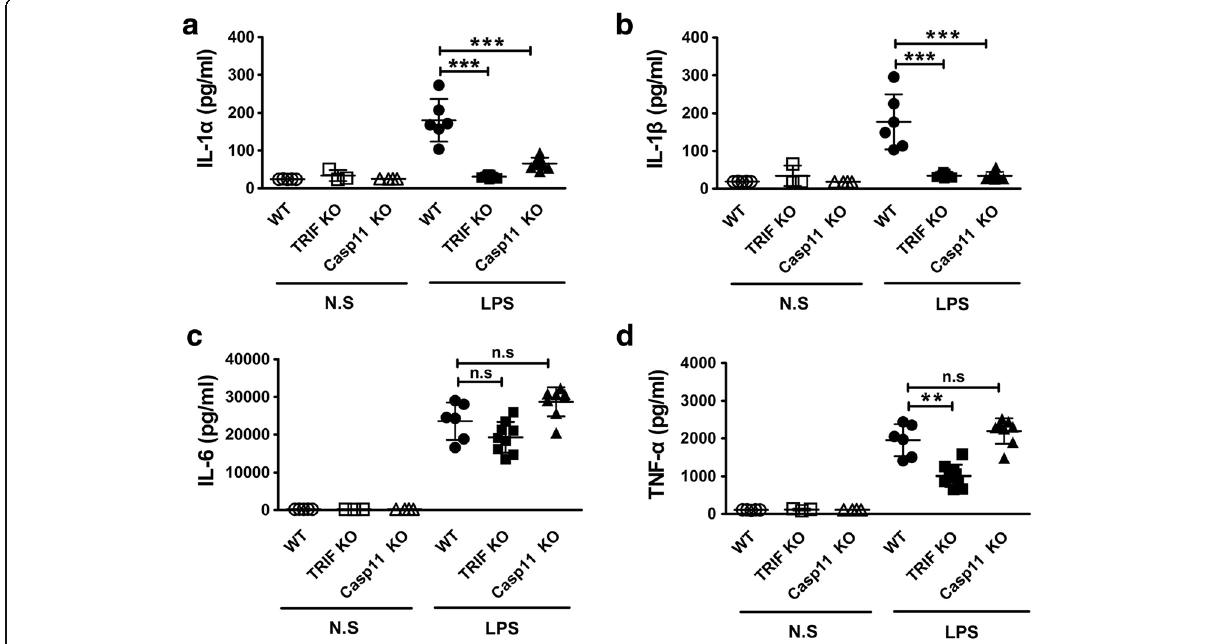
Fig. 1 TRIF is required for caspase-11-dependent immune responses in endotoxemia. Serum IL-1 α ( a ), IL-1 β ( b ), TNF- α ( c ) and IL-6 ( d ) levels from mice of indicated genotypes following intraperitoneal injection with either 10 mg/kg LPS or saline. Serum samples were collected 16 h after LPS injection. * P <0.05; ** P <0.01; *** P <0.001 (Student ’ s t-test). Graphs show the mean ± SD. Data are representative of at least three independent